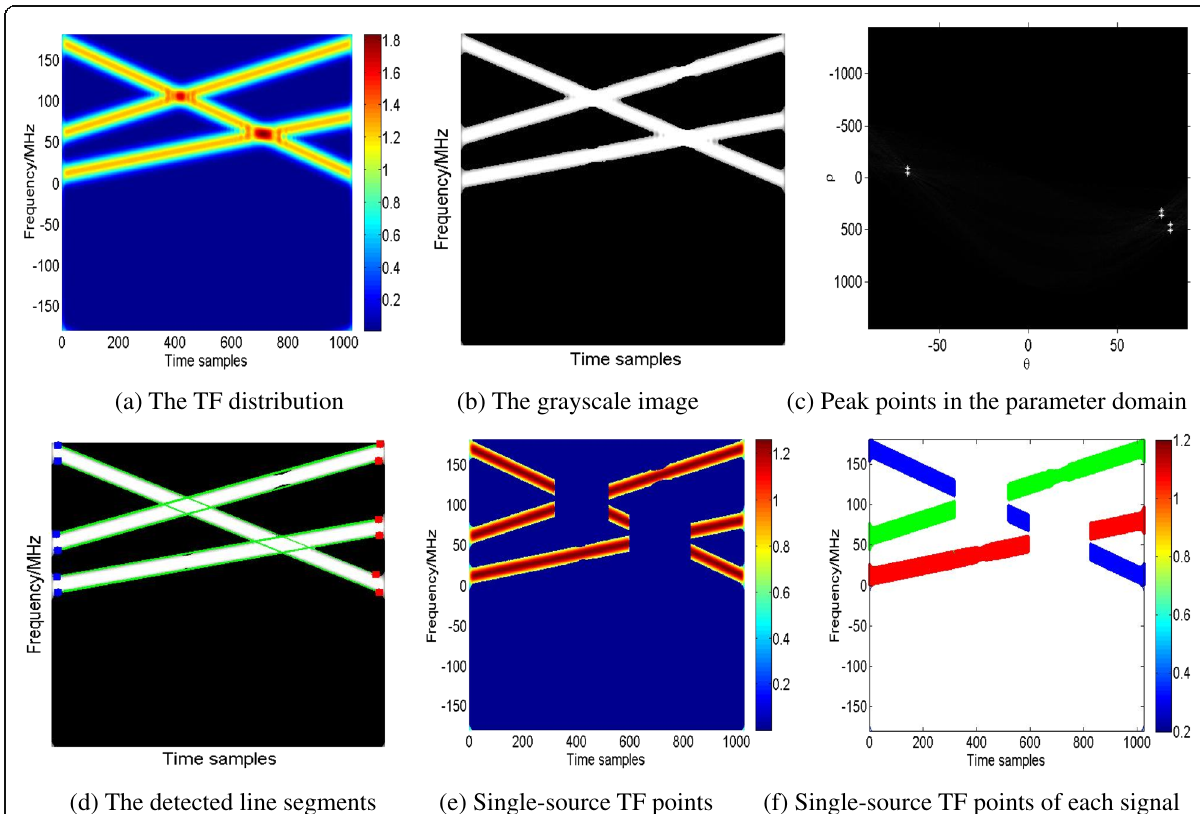
Fig. 3 The single-source TF points selection method, ( a ) the TF distribution, ( b ) the grayscale image, ( c ) peak points in the parameter domain, ( d ) the detected line segments, ( e ) single-source TF points, ( f ) single-source TF points of each signal